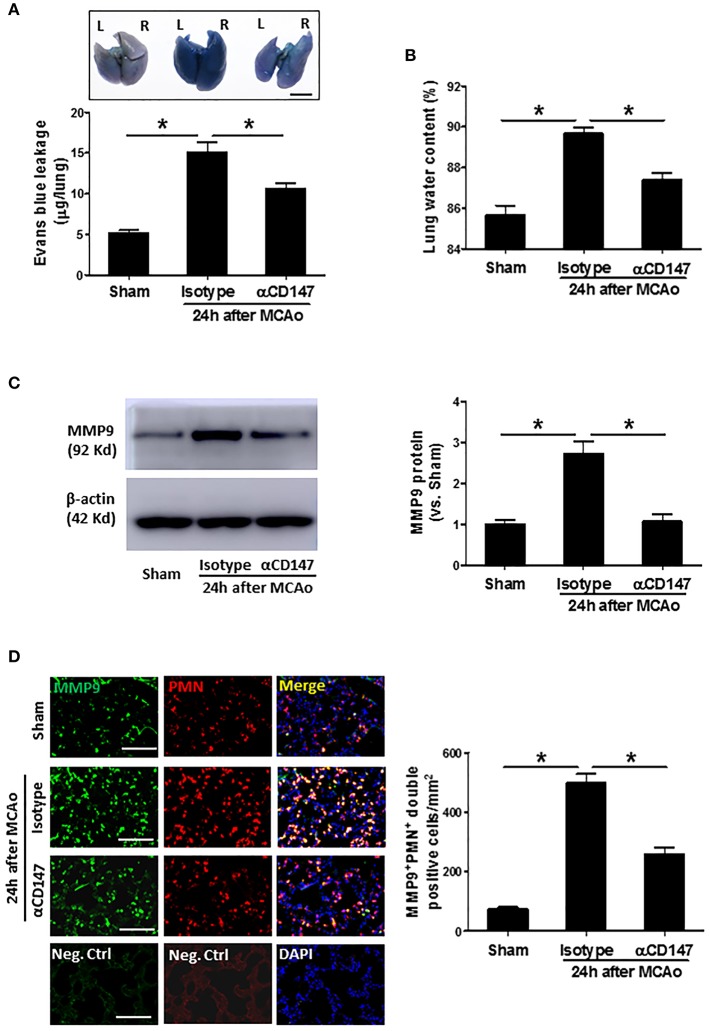
Inhibition of CD147 attenuates post-stroke lung vascular permeability and edema through inhibition of MMP-9 activity. (A) Representative pictures and quantitative analysis of Evans blue leakage in the lung tissue at 24 h after stroke. L: left lung (one lobe), R: right lung (four lobe). Bar = 5 mm. n = 6 per group. (B) Lung water content at 24 h after stroke. n = 6 per group. (C) Representative images of western blots showing MMP-9 protein levels in the lung tissues and semi-quantitative analysis of immunoblots. n = 4 per group. (D) Double immunostaining for MMP-9 and neutrophils in the lung sections in indicated groups at 24 h after stroke (left panel). Neg.Ctrl indicates negative control. Bar = 100 μm. The number of the cells double positively stained for neutrophils and MMP-9 per mm2 was counted (right panel). n = 6–7 per group. *P < 0.05.